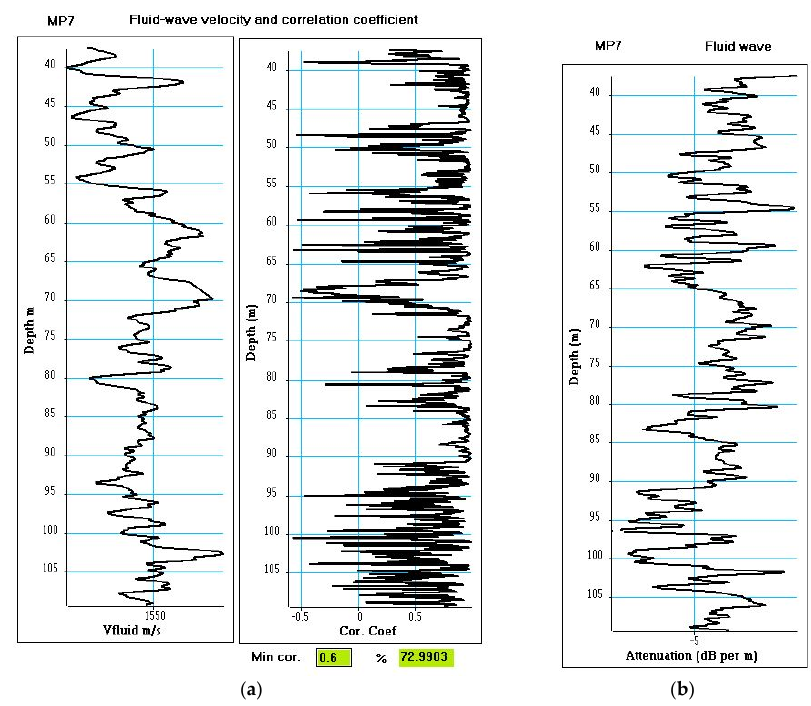
Figure 17. Fluid wave ( a ) velocity and correlation coefficient, ( b ) attenuation.